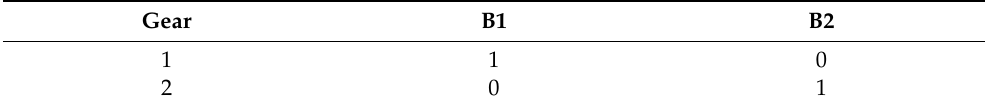
Table 1. Transmission control table.